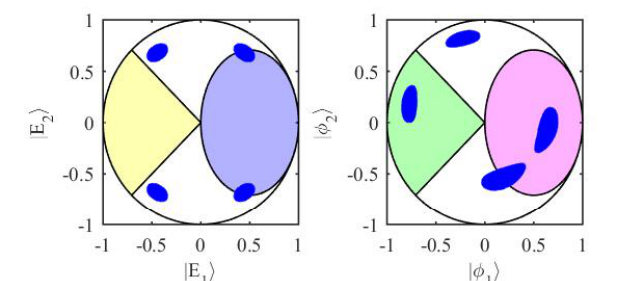
Figure 4. Left) Upper hemisphere is shown with the orthant (yellow) and circular (blue) cones. The blue dots are where a random test vector with time evolution gets close to the R 3 subspace of C 3 , which is spanned by the energy eigenvalues. Right) The subspace is spanned by